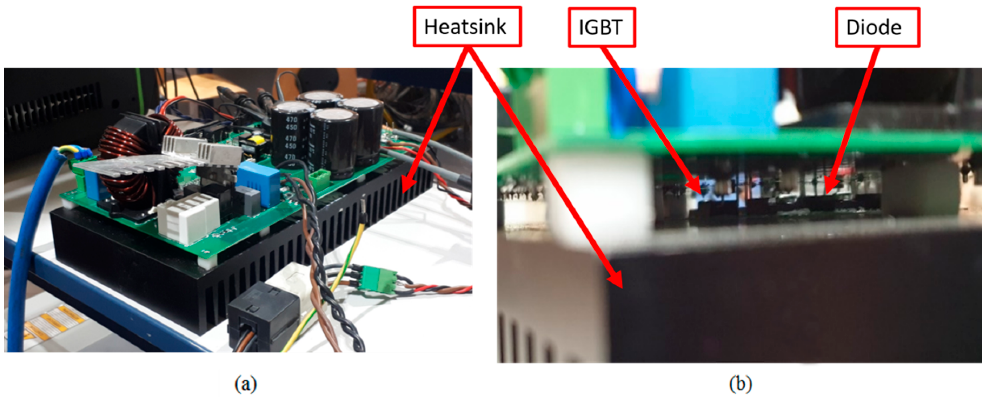
Figure 7. ( a ) Printed Circuit Board (PCB) overview; ( b ) power devices assembled between the PCB and the heatsink.